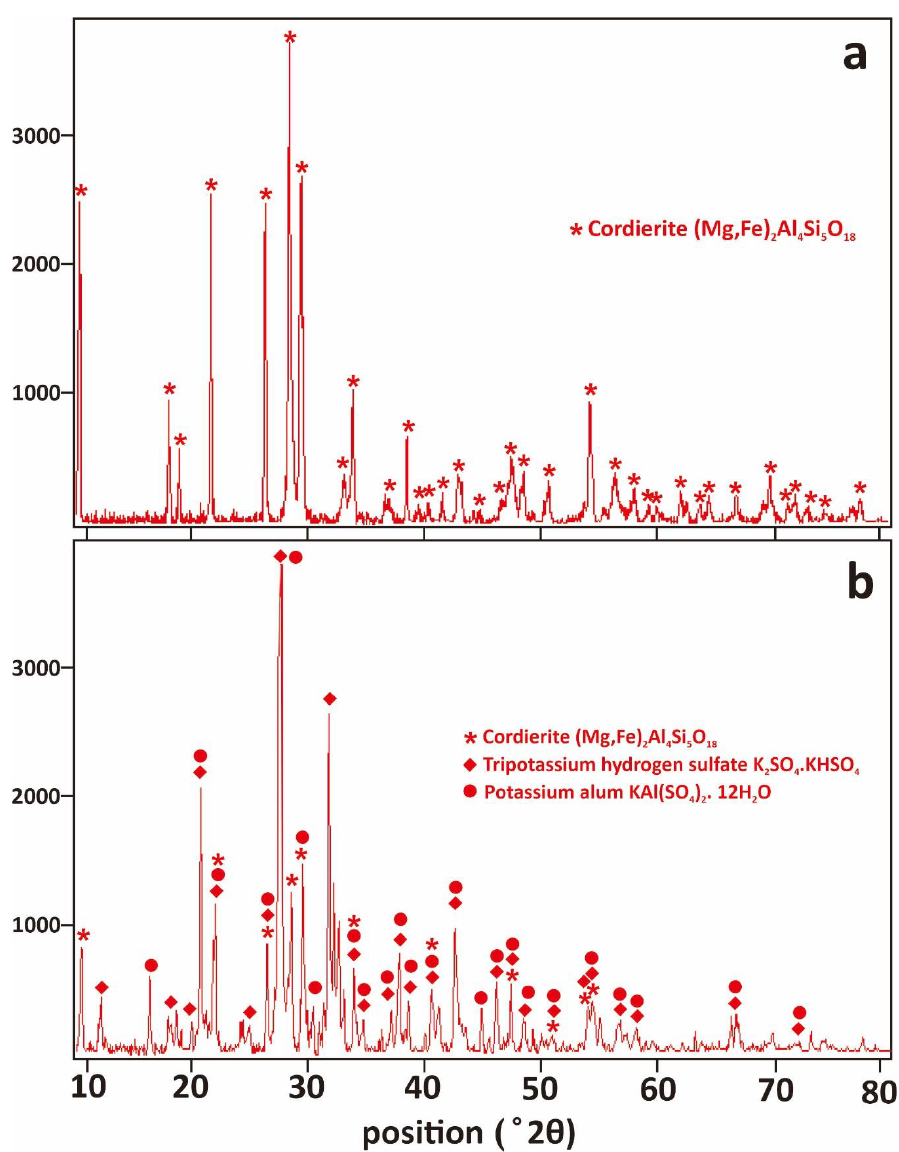
Figure 2. X-Ray powder diffraction of raw materials ( a ) before and ( b ) after fusion with potassium bisulfate.